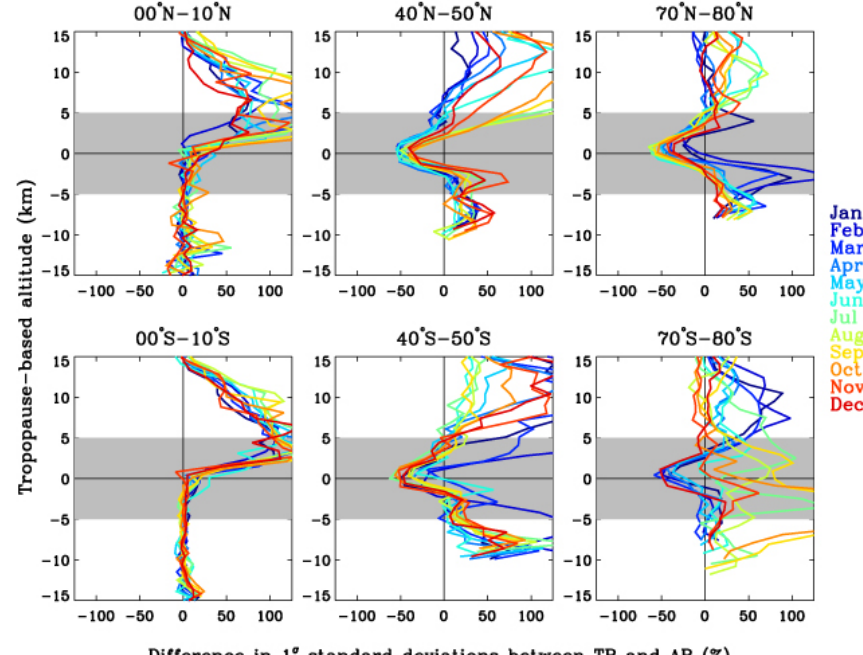
Fig. 1. Relative difference in 1 σ standard deviations between tropopause-based (TB) and altitude-based (AB) climatologies as a function of altitude relative to the corresponding mean tropopause for 12 months at tropical ( ± 5 ◦ ), middle ( ± 45 ◦ ), and high ( ± 75 ◦ ) latitudinal bands. The relative difference is defined as (TB-AB)/AB ×